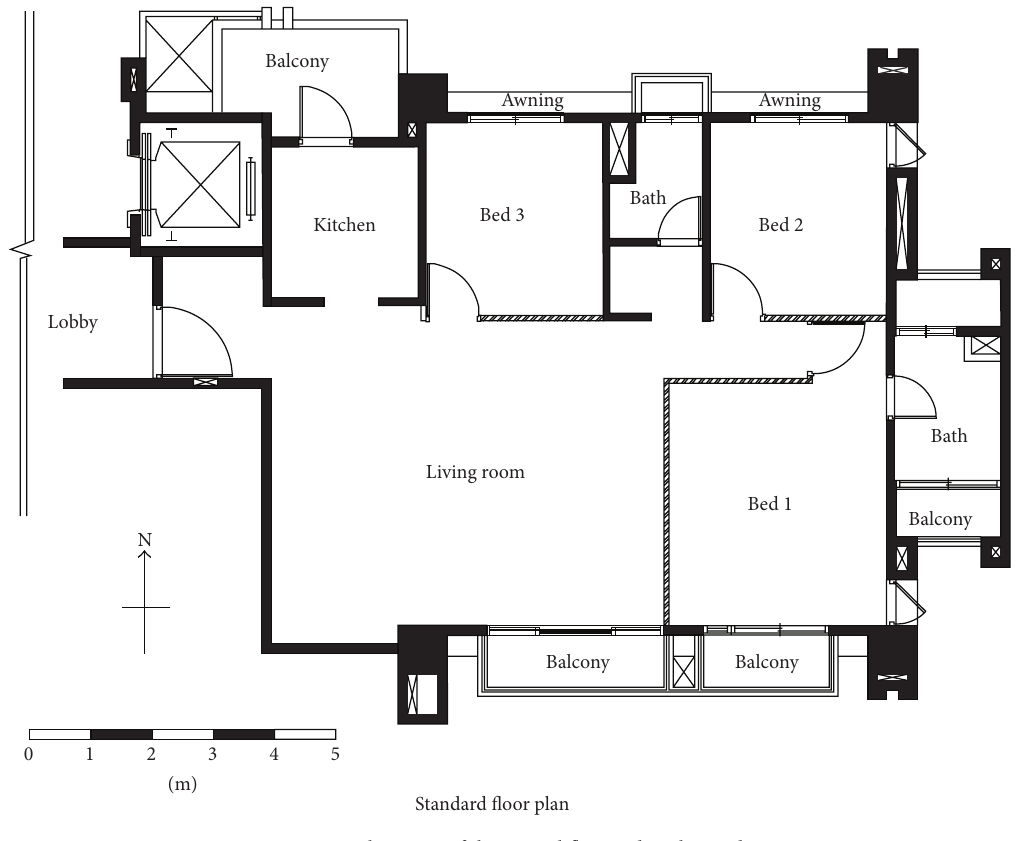
Figure 3: Plan view of the typical flat used in the